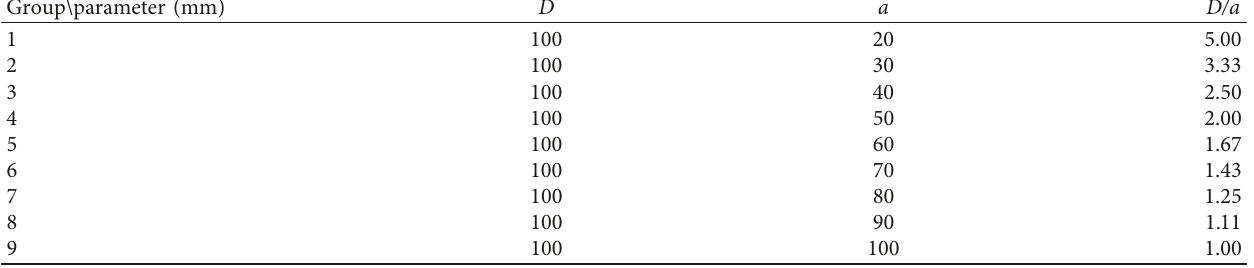
Table 2: The ratios of the cavity and wall ( D/a